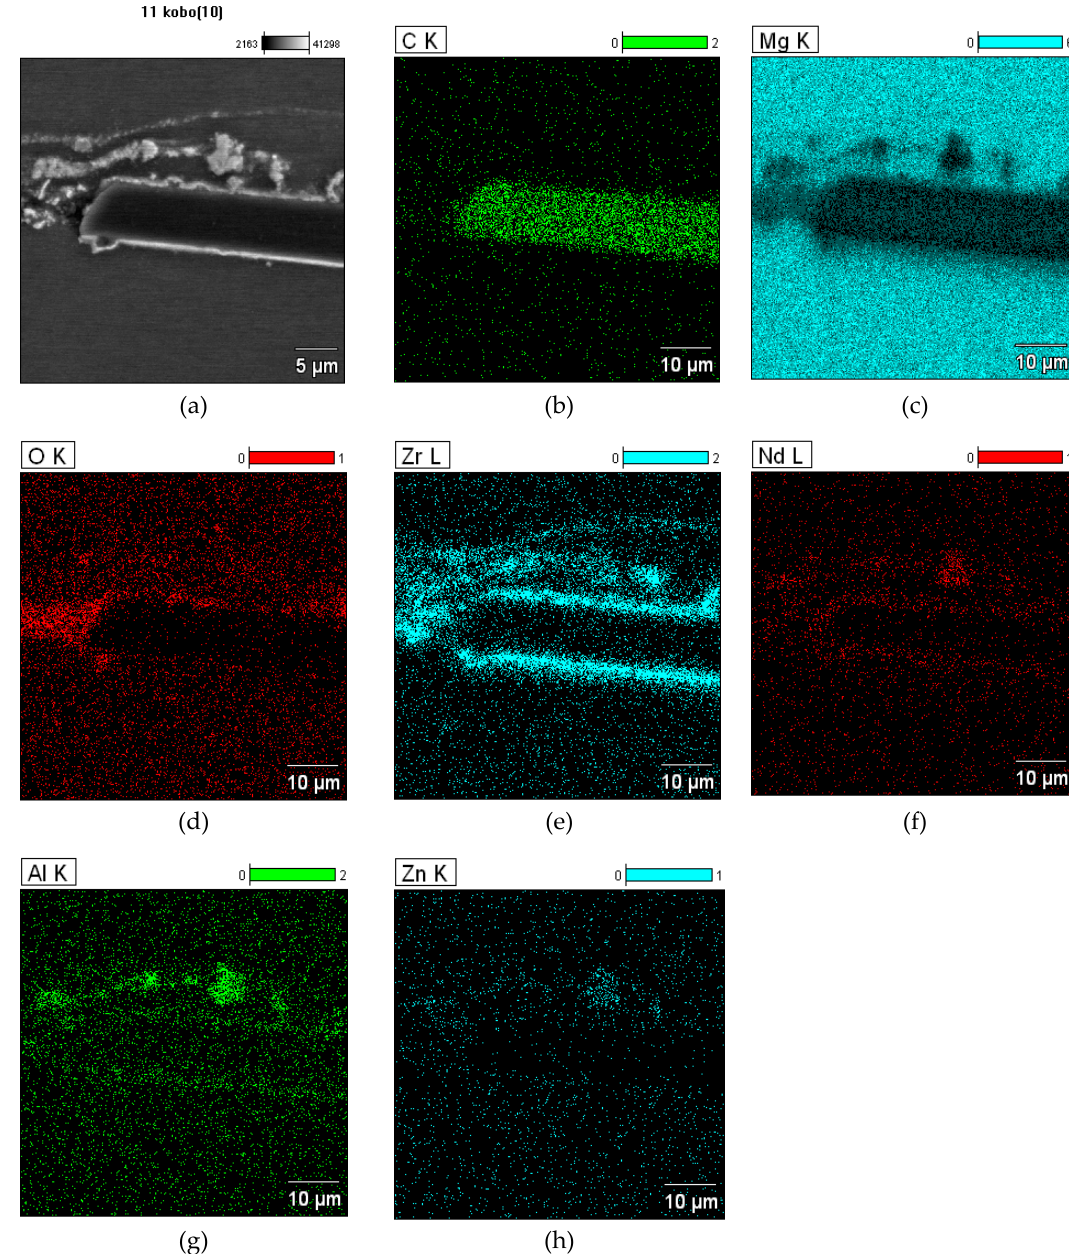
Figure 8. SEM micrograph ( a ) and elemental mapping ( b – h ) of Mg-Csf composite processed by stir casting and then cold extruded by KoBo method.